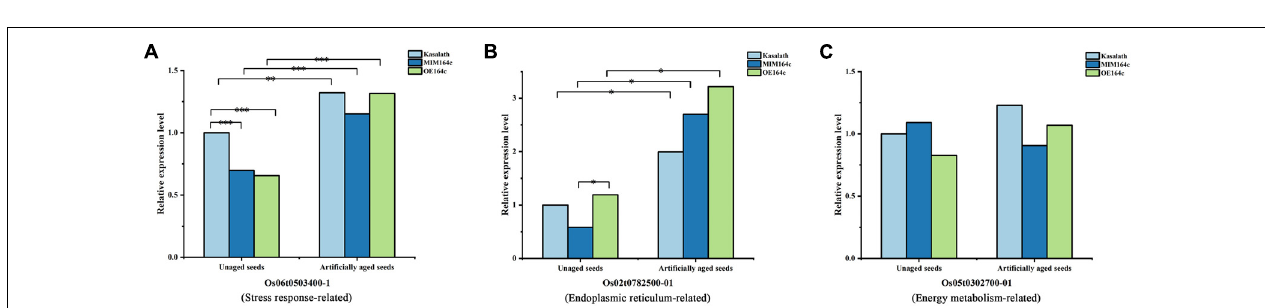
FIGURE 13 | Comparison of the quantitative data of 16 rice seed proteins between MRM-MS and TMT assays. Data represent the mean of three technical replicates. Asterisk ( ∗ ) indicates the significant difference (a linear mixed-effects model was used for MRM data and a paired t -test for TMT data) in the protein expression level between transgenic and WT seeds ( P < 0.05). The expression level of each protein in WT seeds was defined as 1.